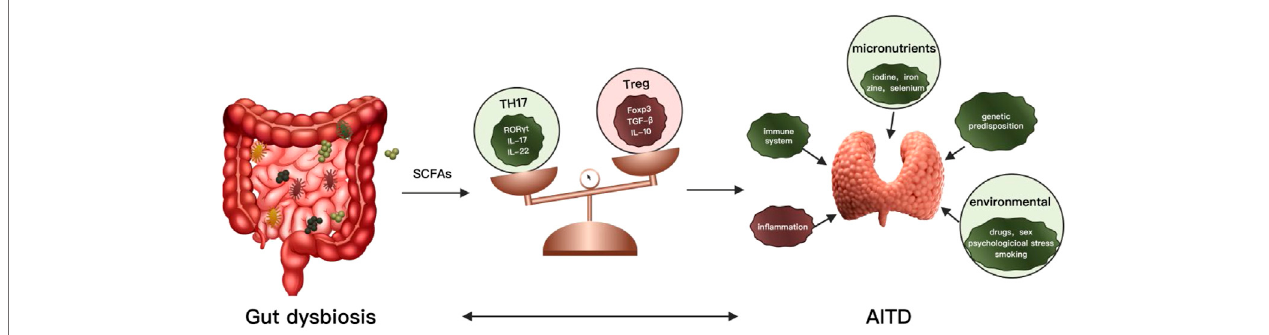
FIGURE 1 | Association between gut microbiota, metabolites, and thyroid autoimmune